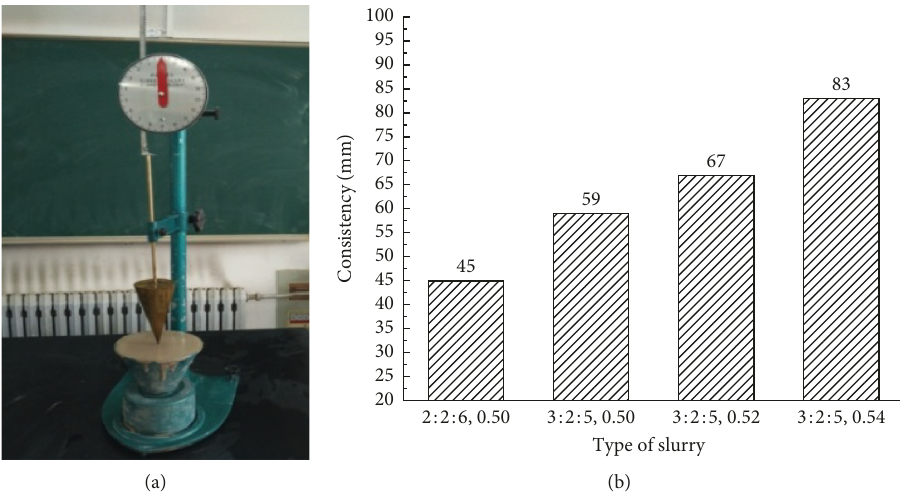
Figure 1: Consistency index test: (a) apparatus for the consistency tests and (b) liquidity index for the four slurry groups.